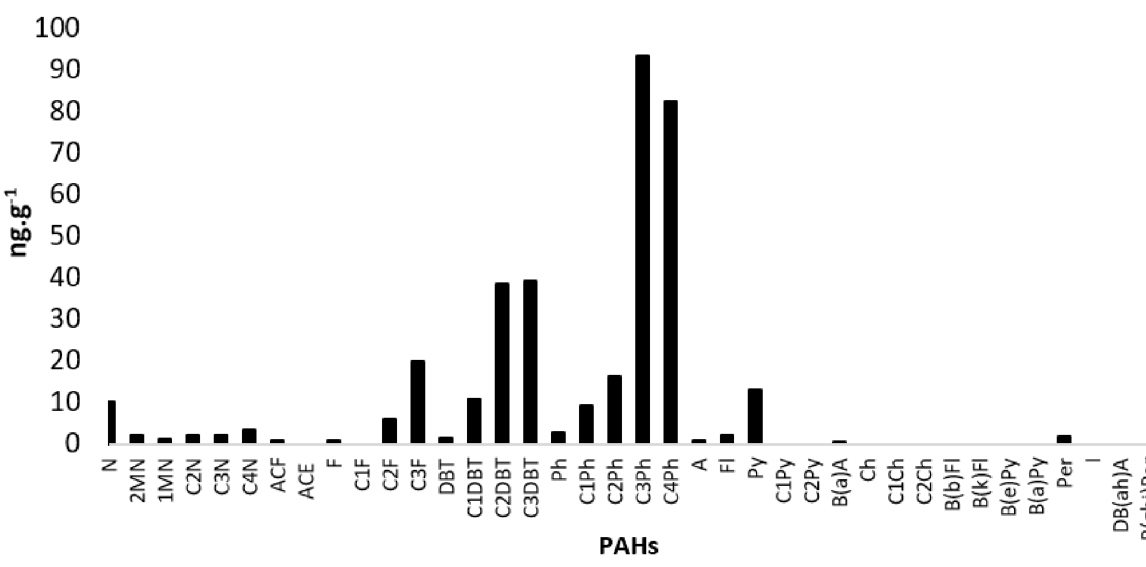
Figure 2. N : Naphthalene ; 2MN: 2Methyl Naphthalene; 1MN: 1Methyl Naphthalene; C2N: C2 Naphthalene; C3N: